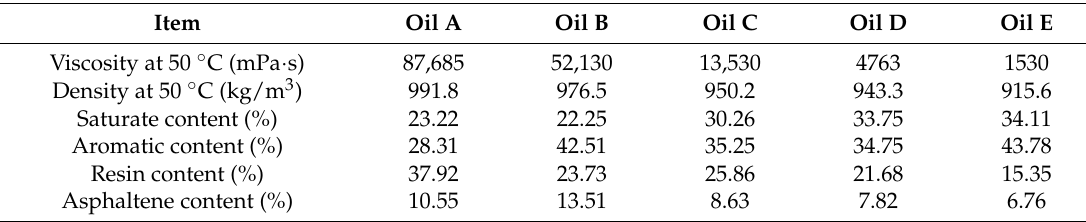
Table 1. Properties of the five dead oils.